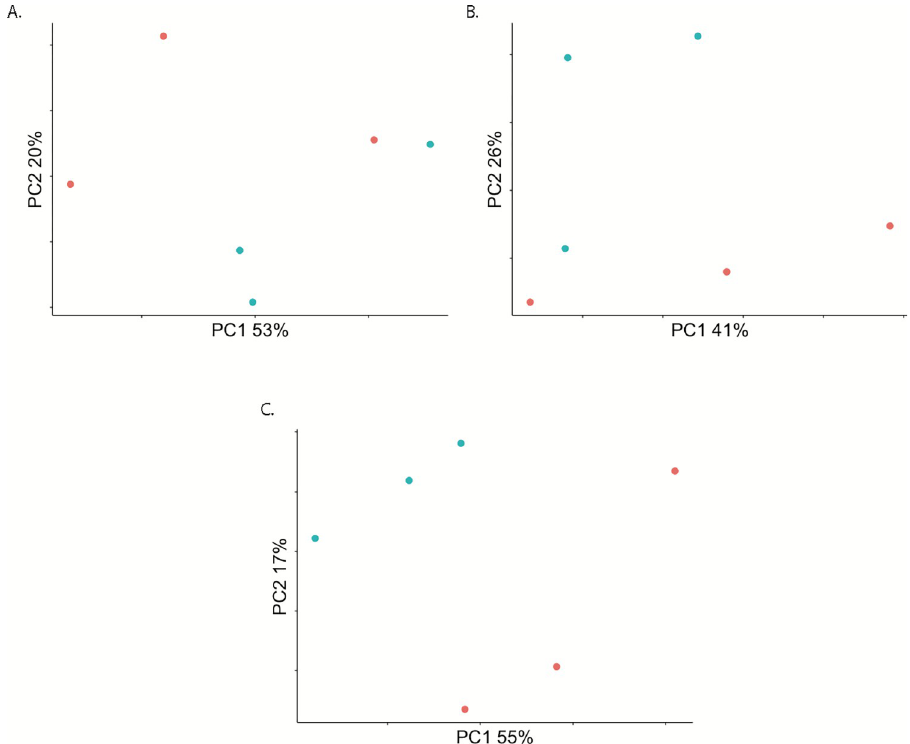
Fig 1. Principal Components Analysis (PCA) on filtered read counts mapping to annotated genes from the AsteI2 build of the An . stephensi genome in Vectorbase. A., B., and C. are read counts from samples in the 2, 7, and 14 dpi groupings respectively. In all PCAs, blue is Mayaro infected, and red are